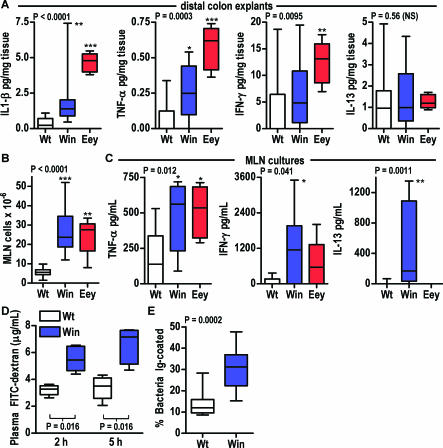
Immunopathology in Mice with Muc2 Mutations(A) Concentrations of IL-1β, TNF-α, IFN-γ, and IL-13 in supernatants from distal colonic explants cultured for 24 h from WT (n = 14), Win (n = 12), and Eey (n = 5) mice at 12–18 wk of age.(B) The number of leukocytes in the MLNs was determined in C57BL/6 (WT, n = 16), Winnie (Win, n = 10), and Eeyore (Eey, n = 5) mice at 12 wk of age.(C) Concentrations of TNF-α, IFN-γ, and IL-13 in supernatants from 2 × 106 MLN leukocytes stimulated with PMA and ionomycin and cultured for 48 h, from WT (n = 11), Win (n = 9), and Eey (n = 5) mice at 12–18 wk of age. For cytokine analysis samples below the sensitivity of each assay were given values of 0.(D) Plasma FITC-dextran concentrations in WT and Win mice (n = 5) 2 and 5 h following oral gavage.(E) The proportion of bacteria coated with immunoglobulin determined by flow cytometry in faecal samples from WT (n = 10) and Win (n = 10) mice.Statistics: box plots show median, quartiles, and range; (A and C) Kruskal-Wallis nonparametric analysis (p-values shown) with Dunn's multiple comparison test (*p < 0.05, ** p < 0.01, ***p < 0.001 versus WT); NS, not significant; (B, D, and E) Mann-Whitney U-test, p-values shown.